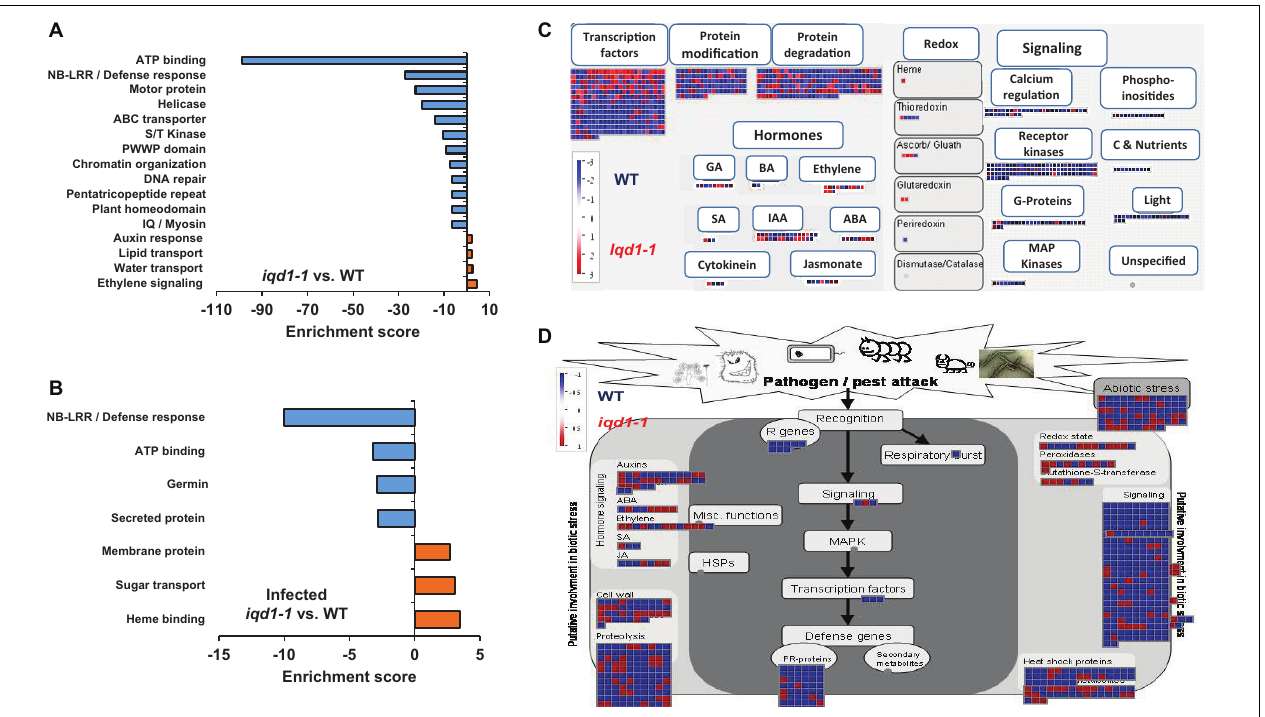
FIGURE 2 | Differentially expressed clusters and genes in iqd1-1 vs. WT plants. Enriched annotation terms of functional-related genes were grouped into clusters using the DAVID bioinformatics resources website. Positive enrichment scores denote upregulated clusters in iqd1-1 lines, while negative values denote up-regulated clusters in WT plants. (A) Differentially expressed clusters and genes in iqd1-1 vs. WT plants. (B) Differentially expressed clusters in infected iqd1-1 vs. infected WT plants. (C,D) . A MapMan regulation overview map showing differences in transcript levels between iqd1-1 and WT plants. Red squares represent higher gene expression in mock treated iqd1-1 plants while blue squares represent higher gene expression in mock-treated WT plants, A regulatory network is presented in (C) , while stress response network is shown in (D) .